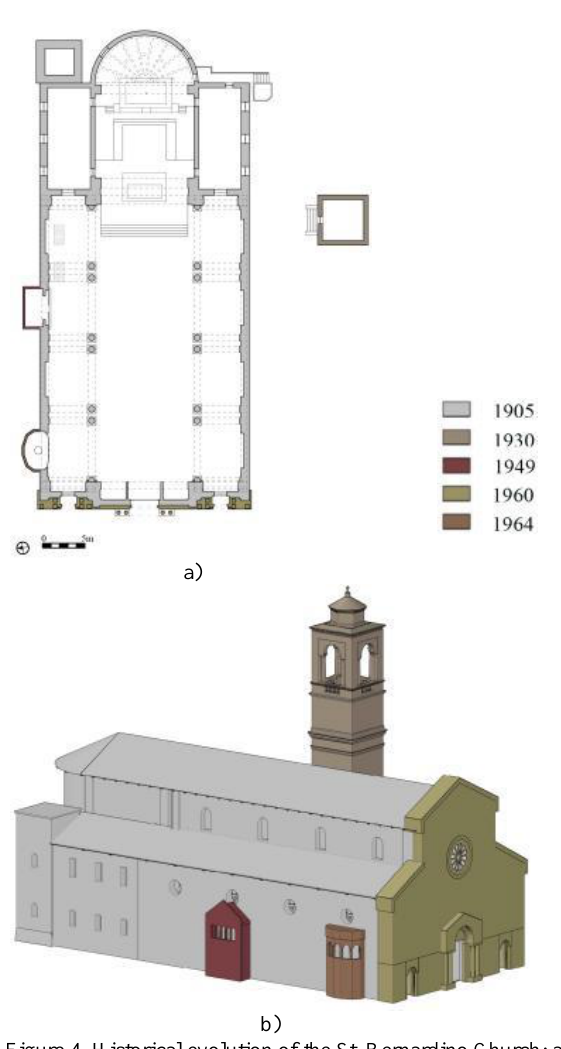
Figure 4. Historical evolution of the St. Bernardino Church: a) plan and b) a three-dimensional digital